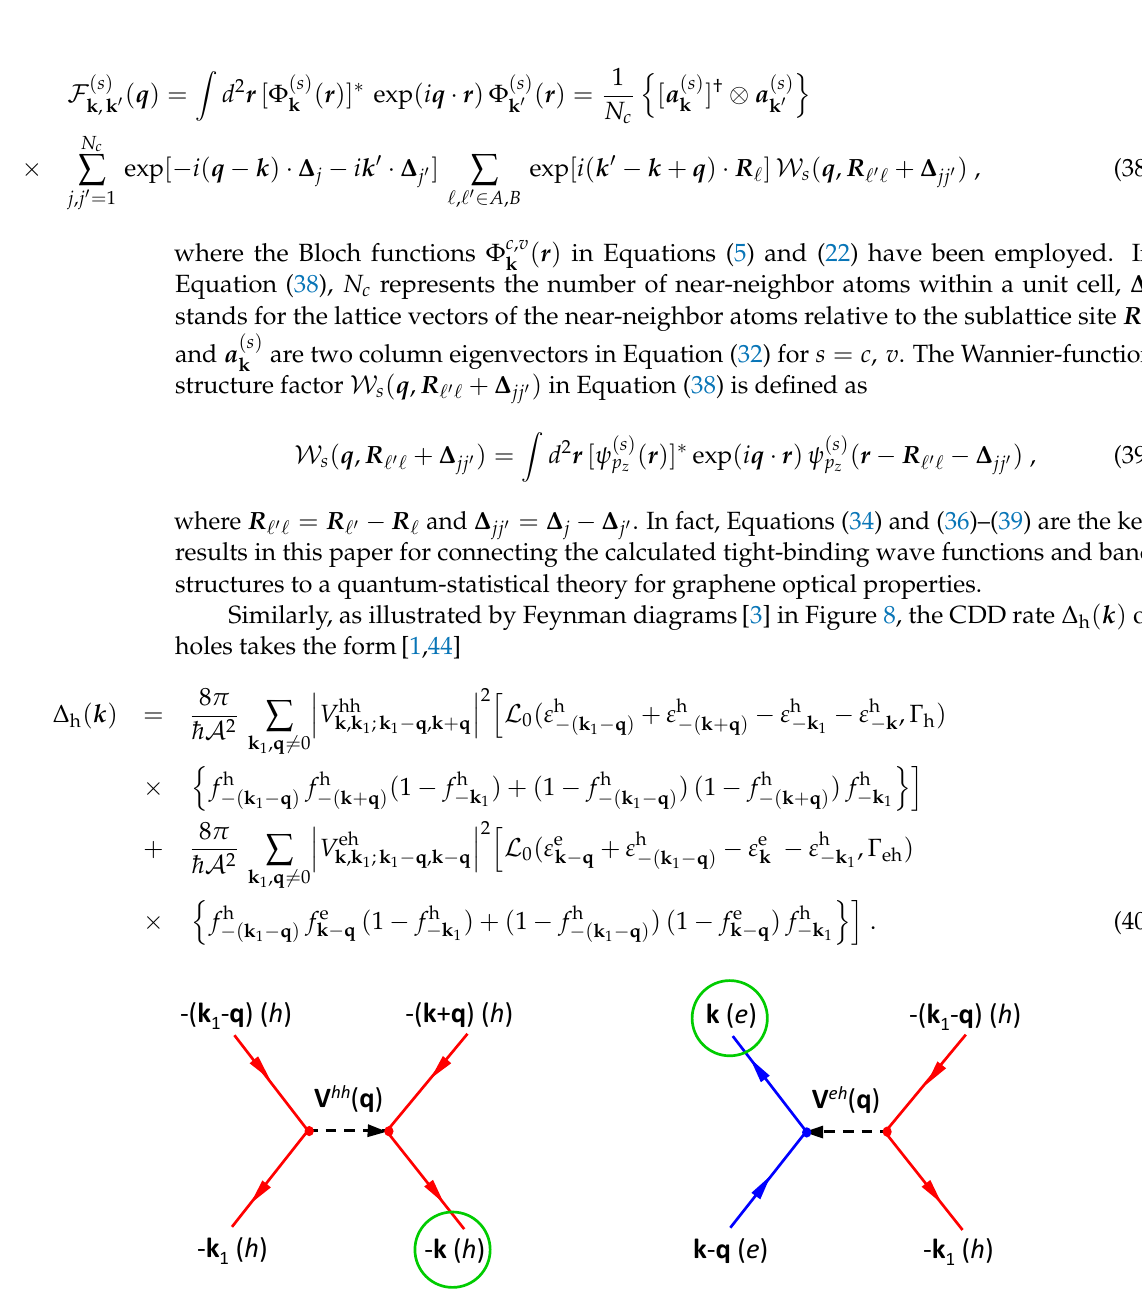
Figure 8. Feynman diagrams for CDD rate ∆ h ( k ) of holes in Equation (40). ( left ) Coulomb coupling between pair of holes in one inelastic-scattering event; ( right ) Coulomb coupling between a hole and an electron in another inelastic-scattering